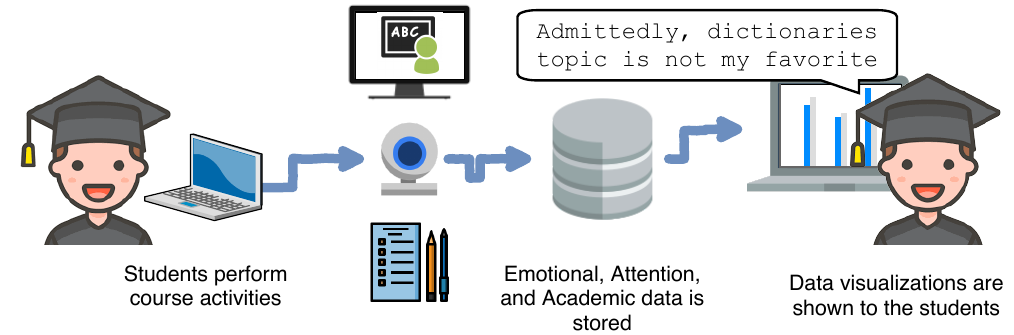
Figure 6. Emotional dashboard for students’ case